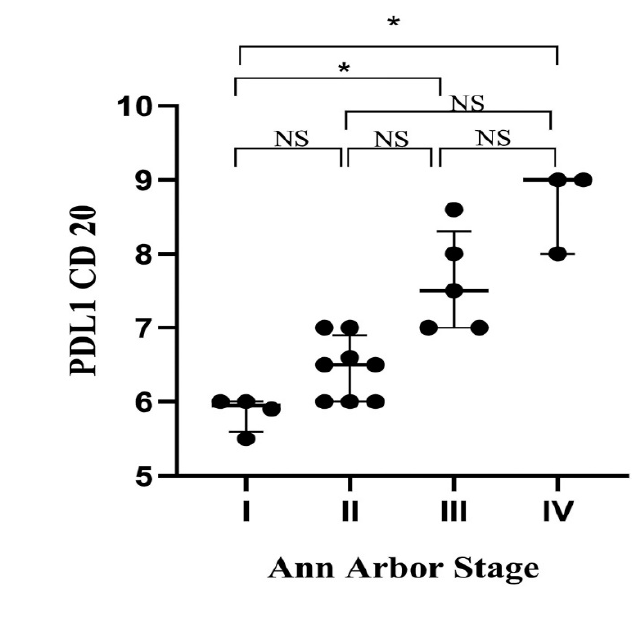
Figure 4. Percentage of PD-L1+CD20+ in post-therapy DLBCL patients. DLBCL type ( A ); Ann Arbor